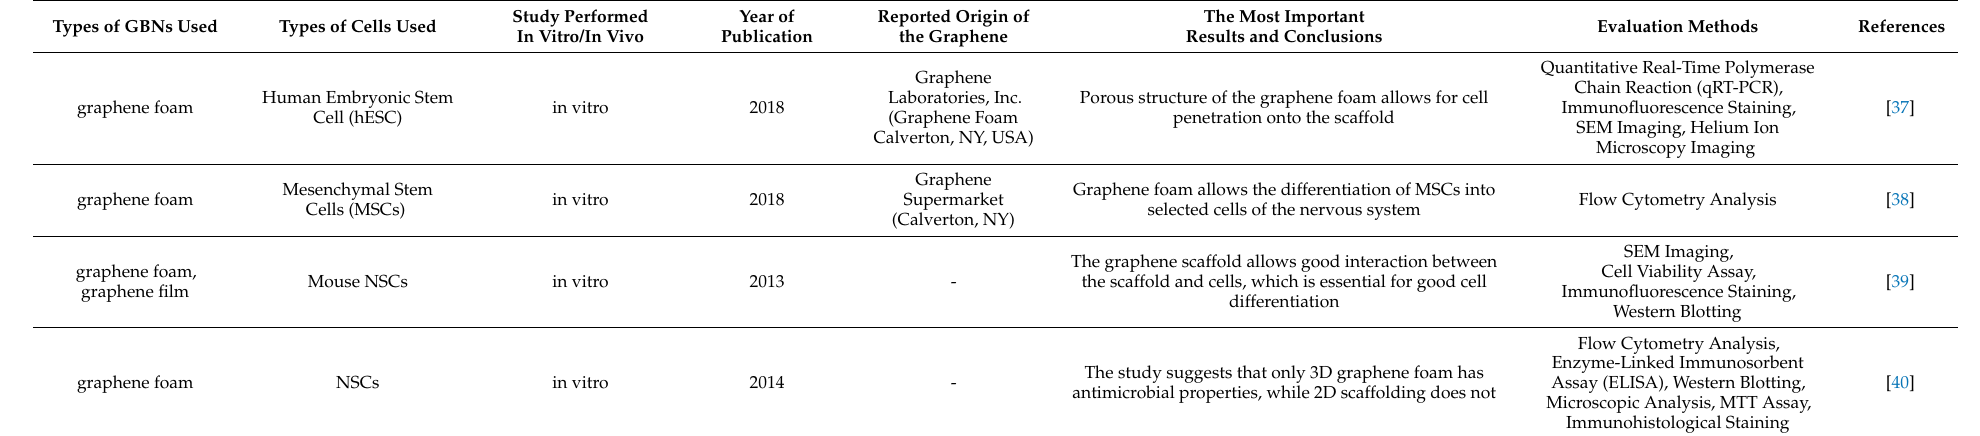
Table 3. List of relevant studies conducted with utilization of graphene